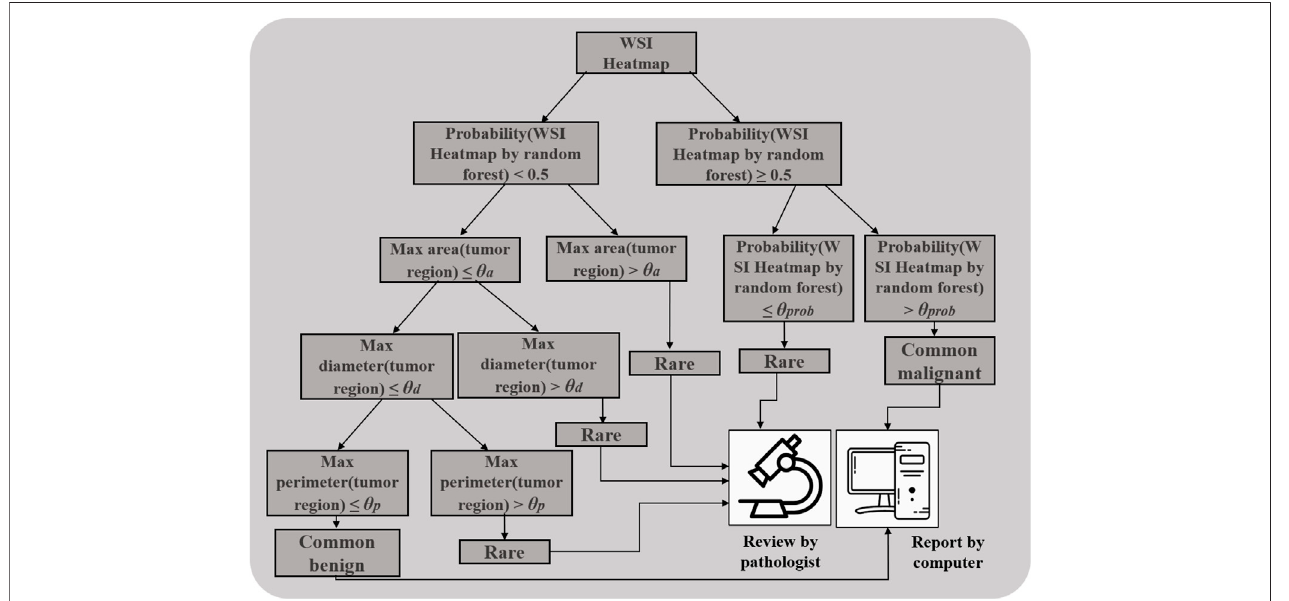
FIGURE 4 | Decision tree for distinguishing the rare from the common benign and malignant categories.